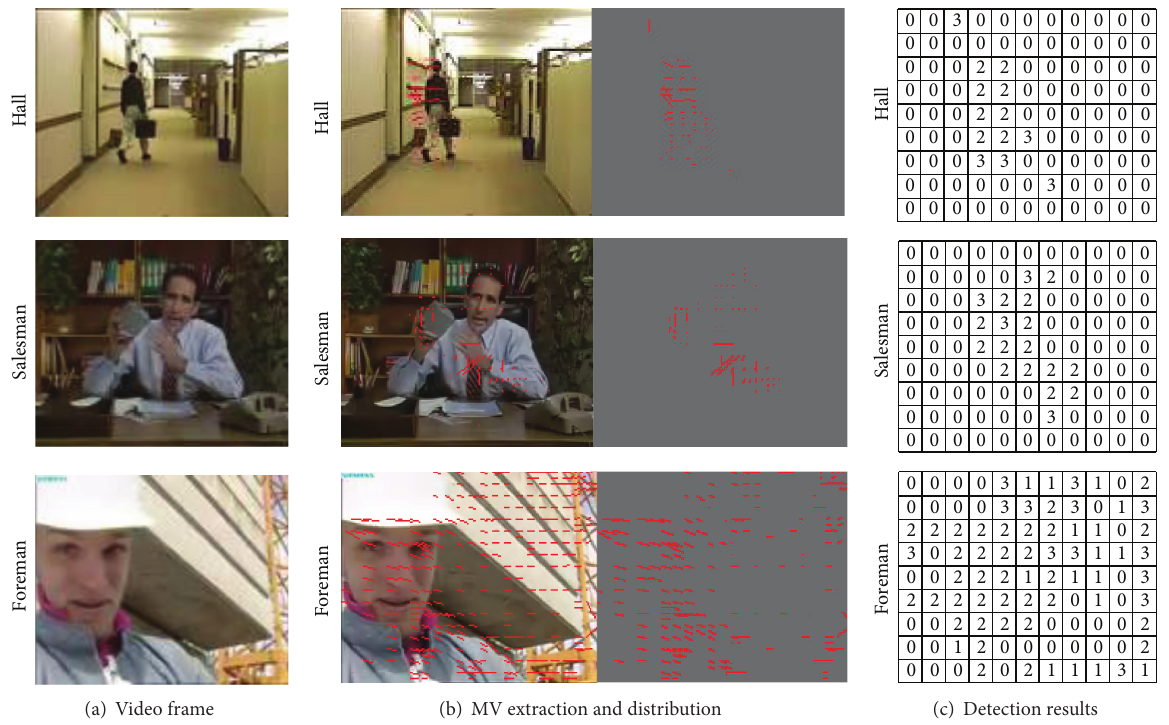
Figure 11: Schematic diagram of temporal saliency detection results based on MV.